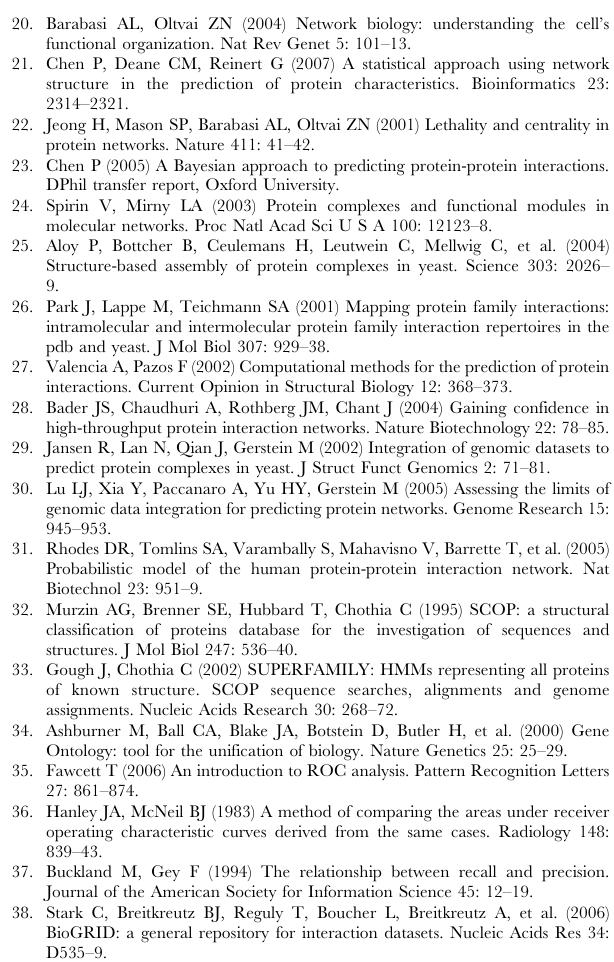
Table S4 List of 24 main functional groups